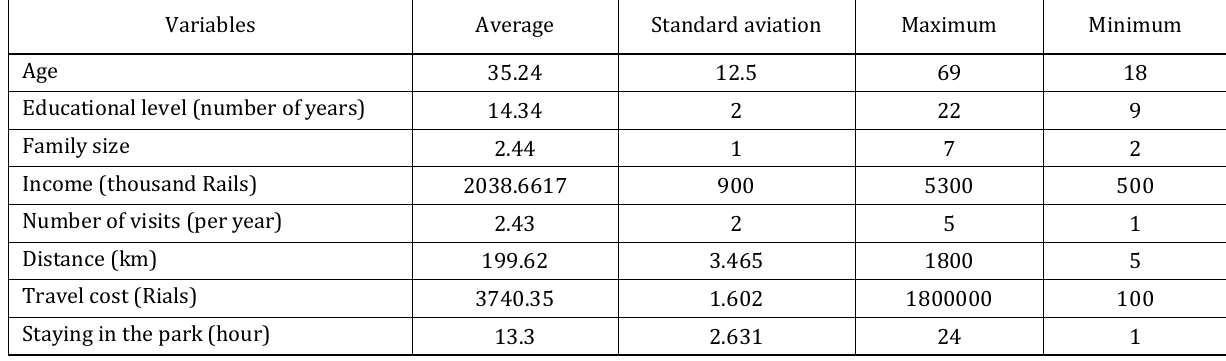
Table 1. Socio-economic characteristics of the forest park’s